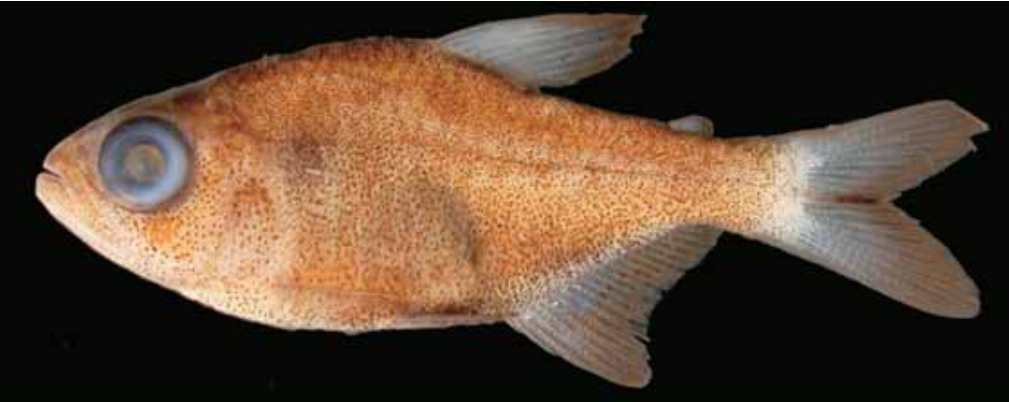
Fig. 6. Hyphessobrycon eilyos , holotype, MZUSP 75126, 22.3 mm SL, Brazil, Mato Grosso, município de Alto Araguaia, ribeirão do